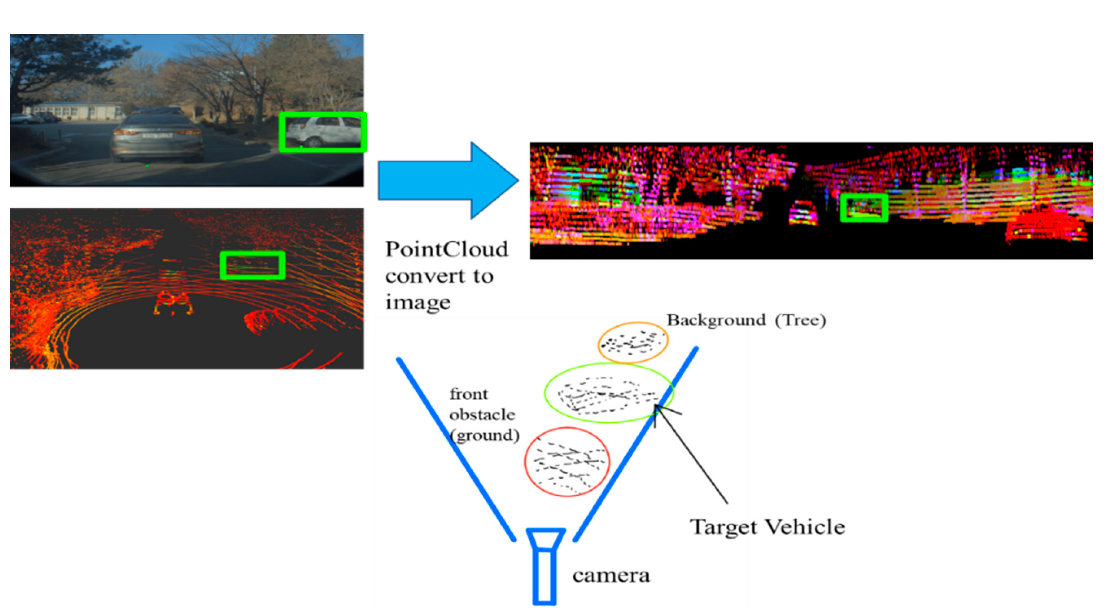
Figure 1. Problems with lidar detection using frustums [29]. Left: Object detected using RGB camera. Right: Detection results in frustum images. Bottom: Obstacles to be removed from frustum image: background (tree) and front obstacle (ground) in the picture.